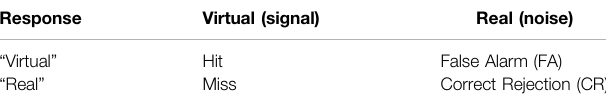
TABLE 3 | Possible outcomes in the Signal Detection